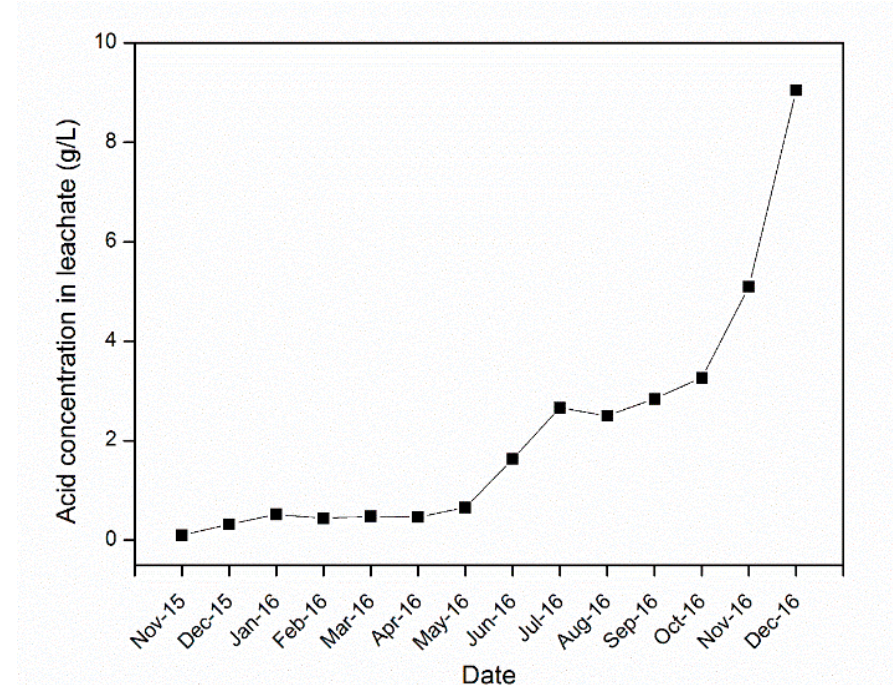
Figure 7. Sulfuric acid concentration of the leachate during the heap bioleaching of P3C6.